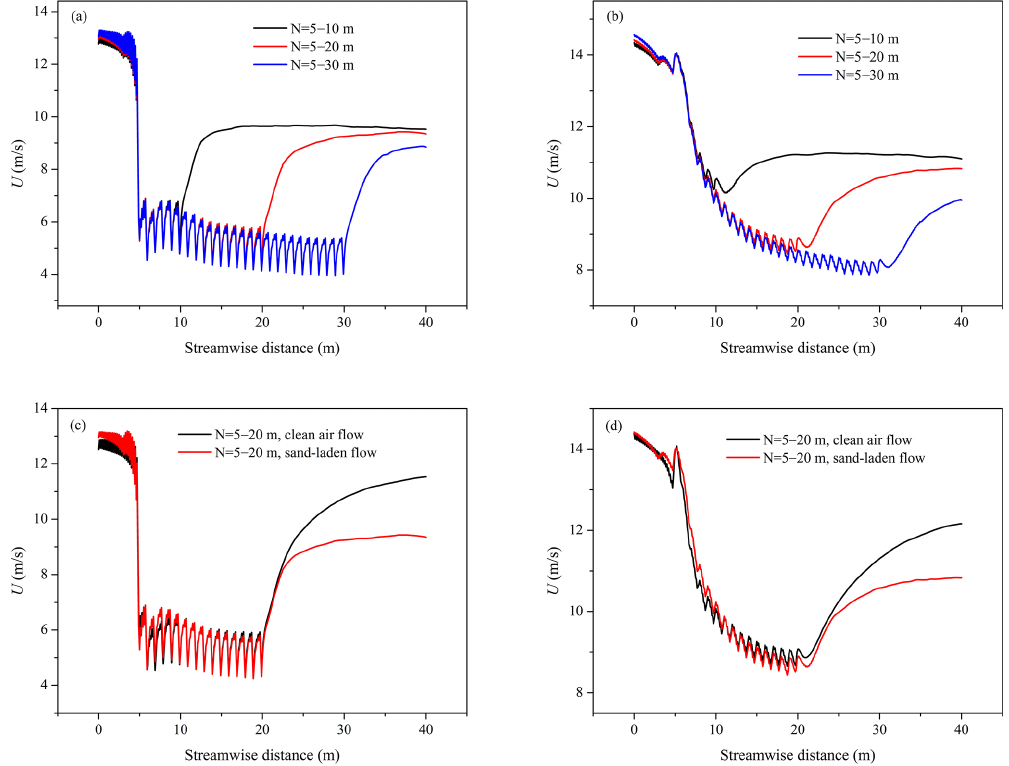
Figure 11. The streamwise wind speed in the sand-laden flow containing the SCBs at the height of 0.1m (a) and the height of 0.2m (b) ( u τ = 0 . 6ms − 1 ; N = 5–10, 5–20, 5–30m). A comparison of the streamwise wind speed between the clean airflow and the sand-laden flow at a height of 0.1m (c) and a height of 0.2m (d) ( u τ = 0 . 6ms − 1 ; N = 5–20m) is also shown.